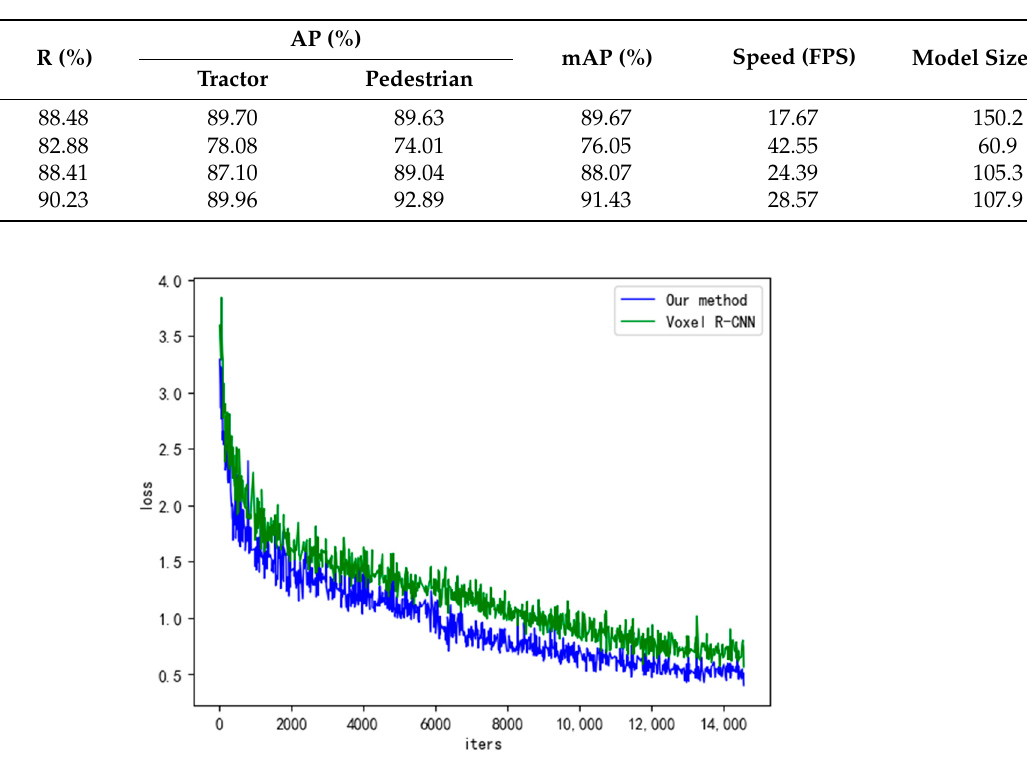
Table 2. Comparative experimental results of different obstacle detection methods.